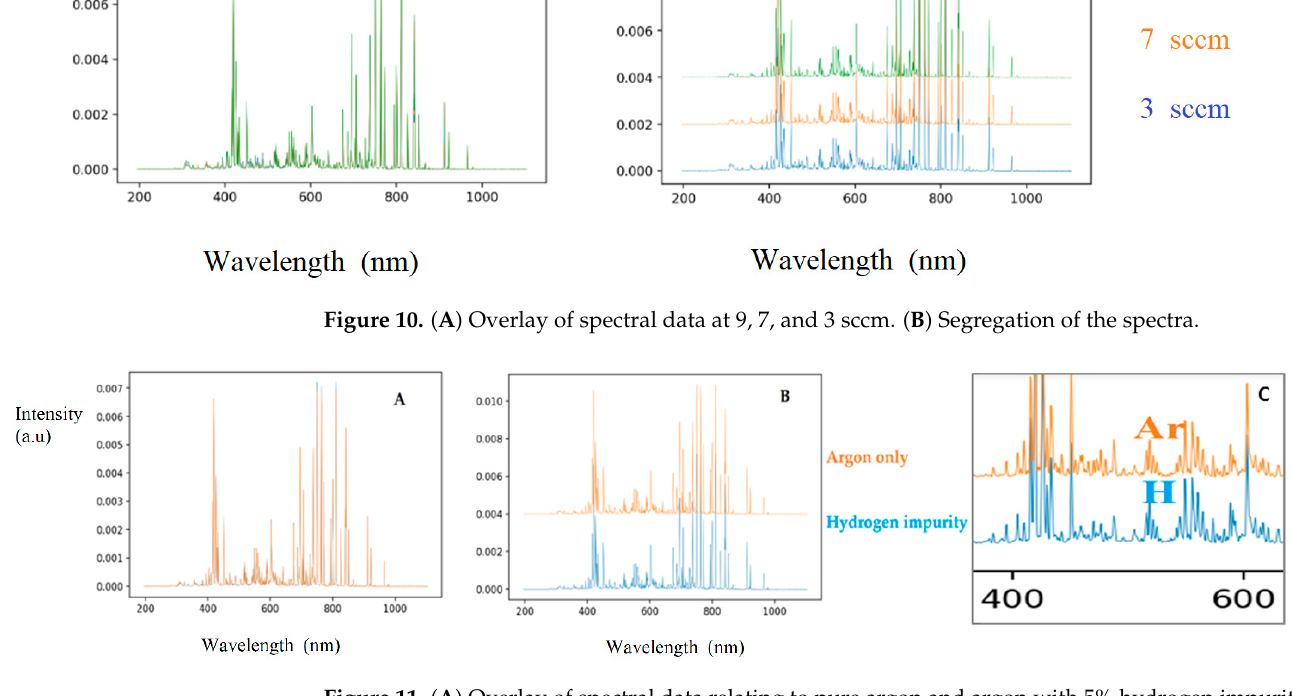
Figure 11. ( A ) Overlay of spectral data relating to pure argon and argon with 5% hydrogen impurity. ( B ) Segregation of the same spectra. ( C ) Section of the spectra magnified to illustrate the miniscule variation in the spectral data and the precision with which the CNN model works to identify the differences in the spectral data for correct predictions and classification.